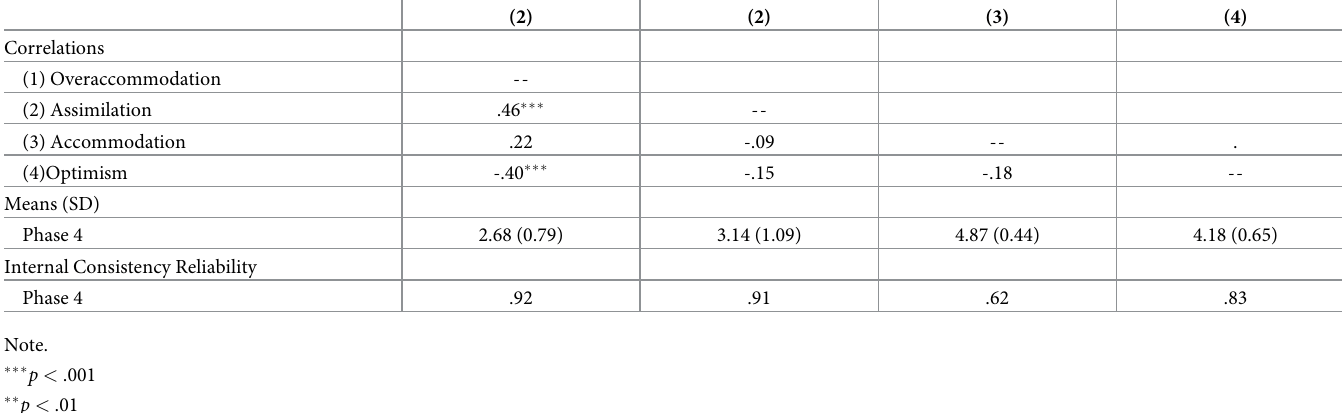
Table 6. Descriptive statistics, inter-scale correlations, and internal consistency reliability estimates of the 69-item TRCS subscales in Phase 4 clinical sample ( N = 73).